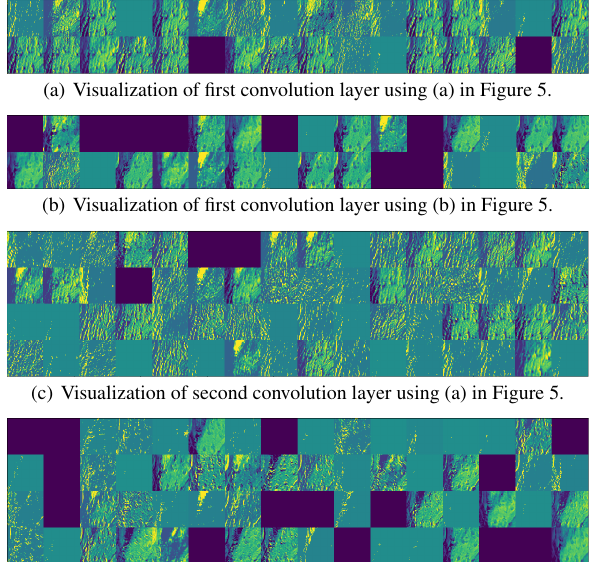
(d) Visualization of second convolution layer using (b) in Figure 5. Figure 6. The results of visualization from convolution layers When the convolution layer is activated, there is a clear dif- ference between the data, as shown in Figure 6 using the data [Figure 5]. The Non-RTI-data model learned the shape such as line or color, on the other hand, the RTI-data model learned the depth information in addition to the shape. Moreover, the